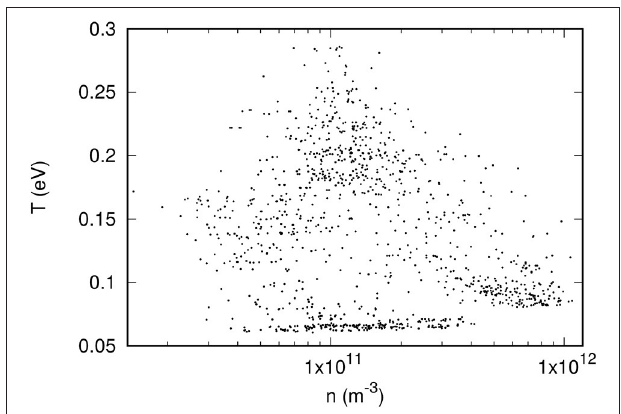
T ionospheric-relevant parameter space −